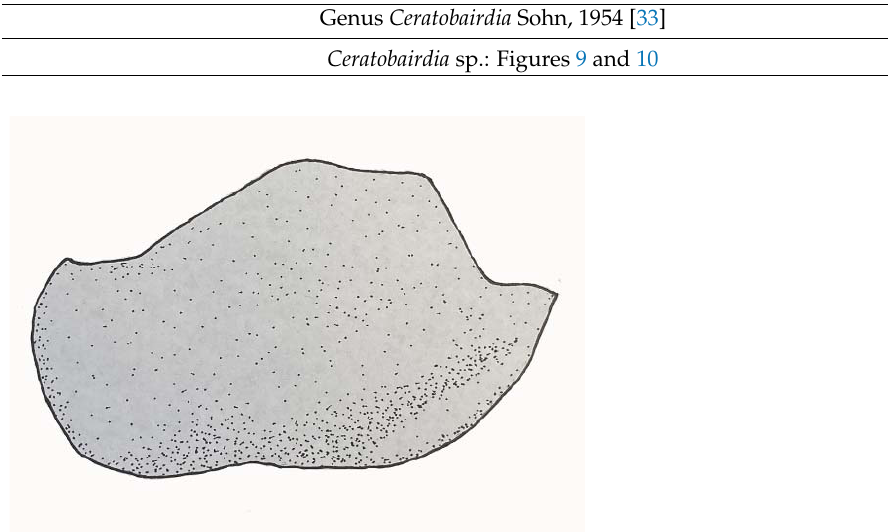
Figure 9. Ceratobairdia sp., right valve, lateral view. IGM 5011(6). Width of valve 1.2 mm. Image credit: Mark McMenamin.